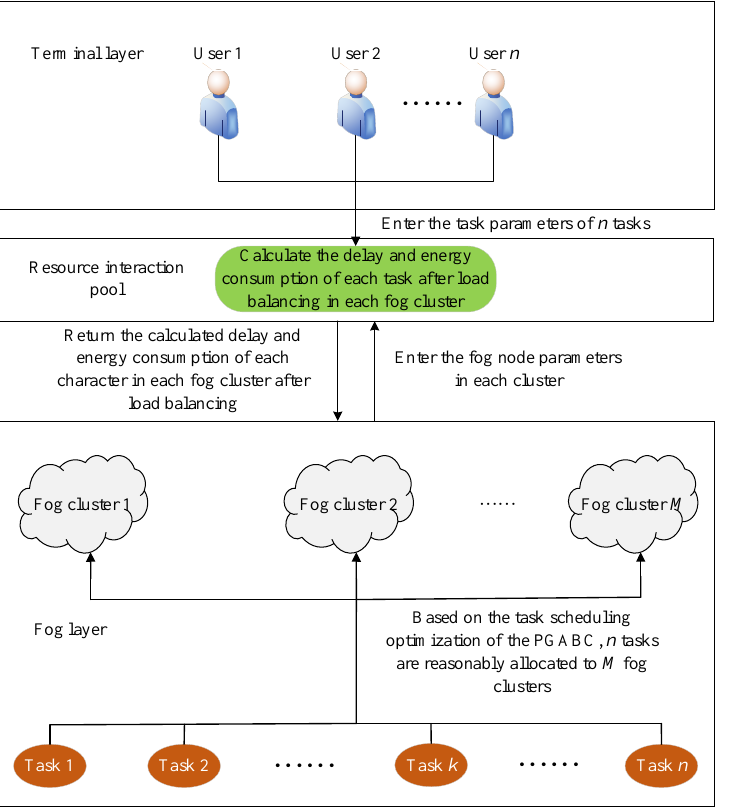
Figure 1. Two-layer fog computing resource-scheduling architecture based on load balancing and task scheduling. task